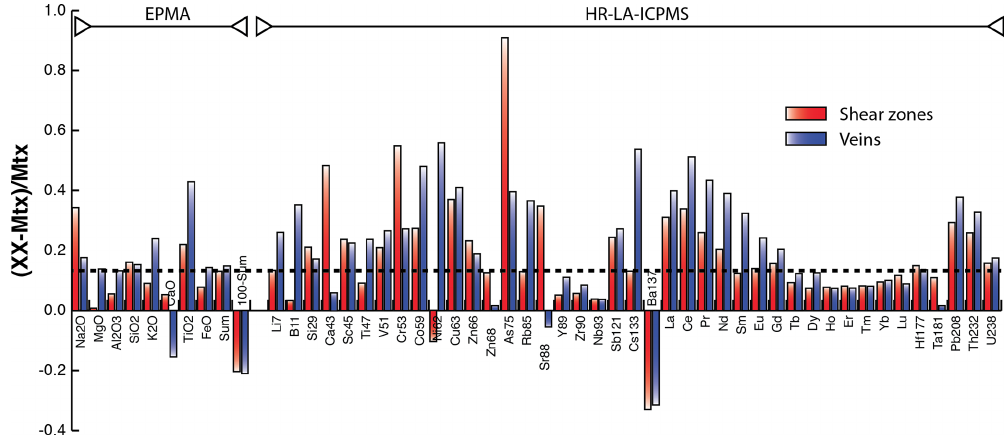
Figure 10. Average relative proportions of major-element concentrations (measured by EPMA on samples 4R-3, 73-76; 11R-6, 3-8; and 21R-2, 82-85) and trace-element concentrations (measured by HC-LA-ICPMS on sample 21R-2, 82-85) in shear zones (red bars) and in veins (blue bars) with respect to their host sediment matrix. The dashed horizontal line corresponds to the averaged enrichment of major elements from the matrix (Mtx) to the deformation bands (XX), assumed to represent mechanical